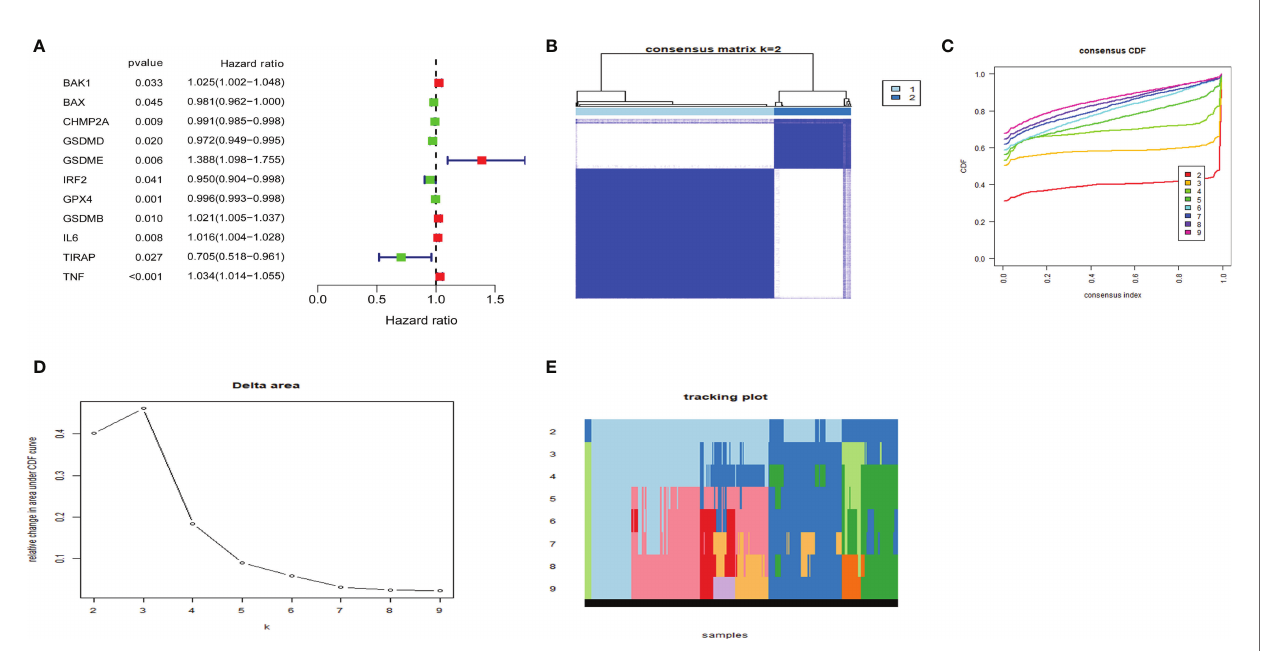
FIGURE 6 | Consensus clustering of pyroptosis-related genes regrouped uterine corpus endometrial carcinoma (UCEC). (A) Identi fi cation of pyroptosis-related gene by univariate Cox regression analysis. (B) Correlation between Clusters 1 and 2. (C) Consensus clustering cumulative distribution function (CDF) for k = 2 – 9. (D) Relative change in area under CDF curve for k = 2 – 9. (E) The tracking plot for k = 2 –